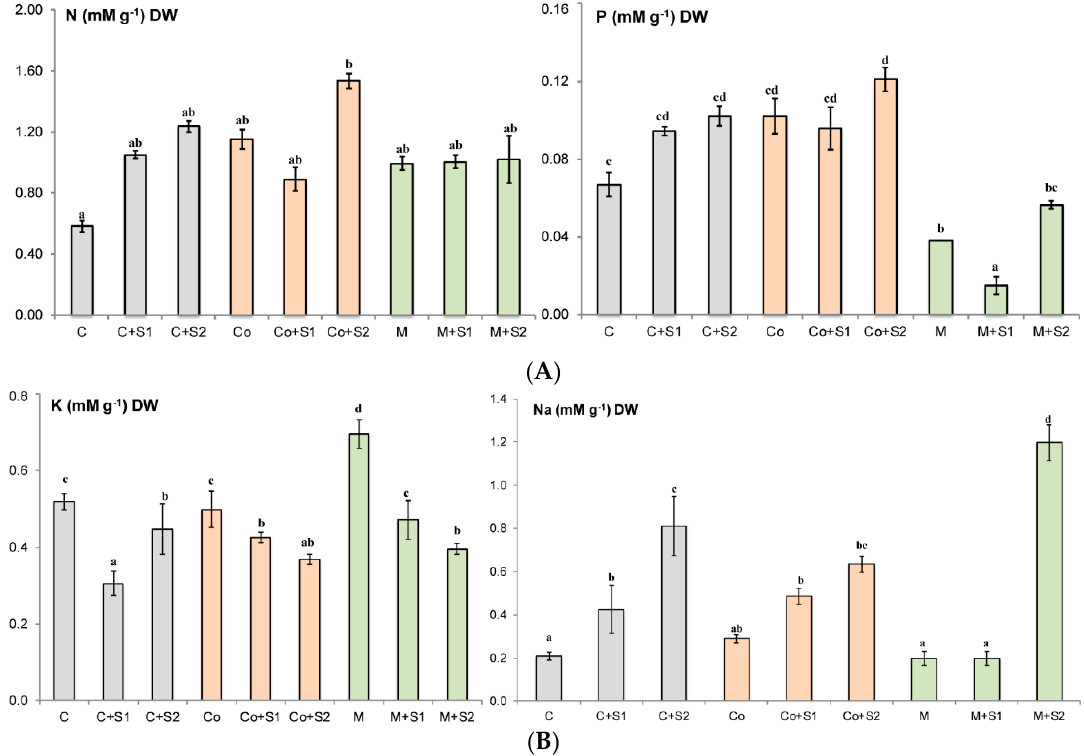
Figure 2. ( A ) Phosphorus (P), nitrogen (N) contents in above ground biomass of Medicago sativa plants cultivated for six months on clayey soils with or without MSW Compost (Co) or farmyard manure (M) and irrigated with 0 mM, 50 mM (S1), 100 mM(S2) NaCl water. Data are means of six repeats ± SE. The different letters ( abcd ) represent a significant difference between treated samples. p < 0.05 by Duncan’s multiple range test; ( B ) the concentration of potassium (K) and sodium (Na) in shoots of alfalfa grown for six months on clay soils amended with or without MSW Compost (Co) or farmyard manure (M) and irrigated water containing 0 mM, 50 mM (S1), 100 mM (S2) NaCl. Data are means of six repeats ± SE. The different letters ( abcd ) represent a significant difference between treated samples. p < 0.05 by Duncan’s multiple range test.